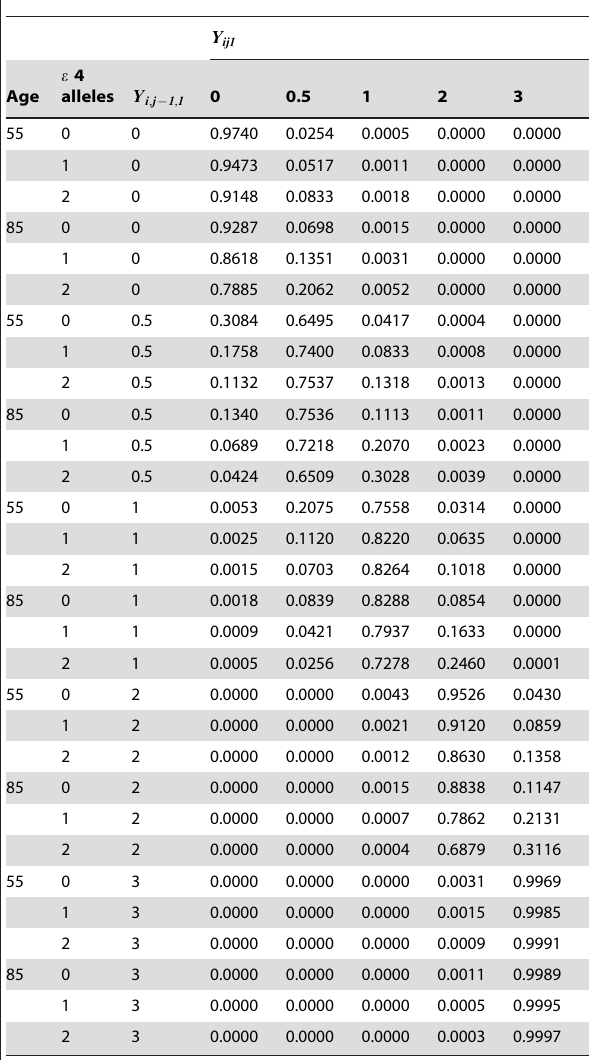
Table 4. The estimated transition probability matrix of functional activities (FAQ) in Alzheimer’s disease patients at the age of 55 or 85 and carrying no, one, or two APOE- e 4 alleles.